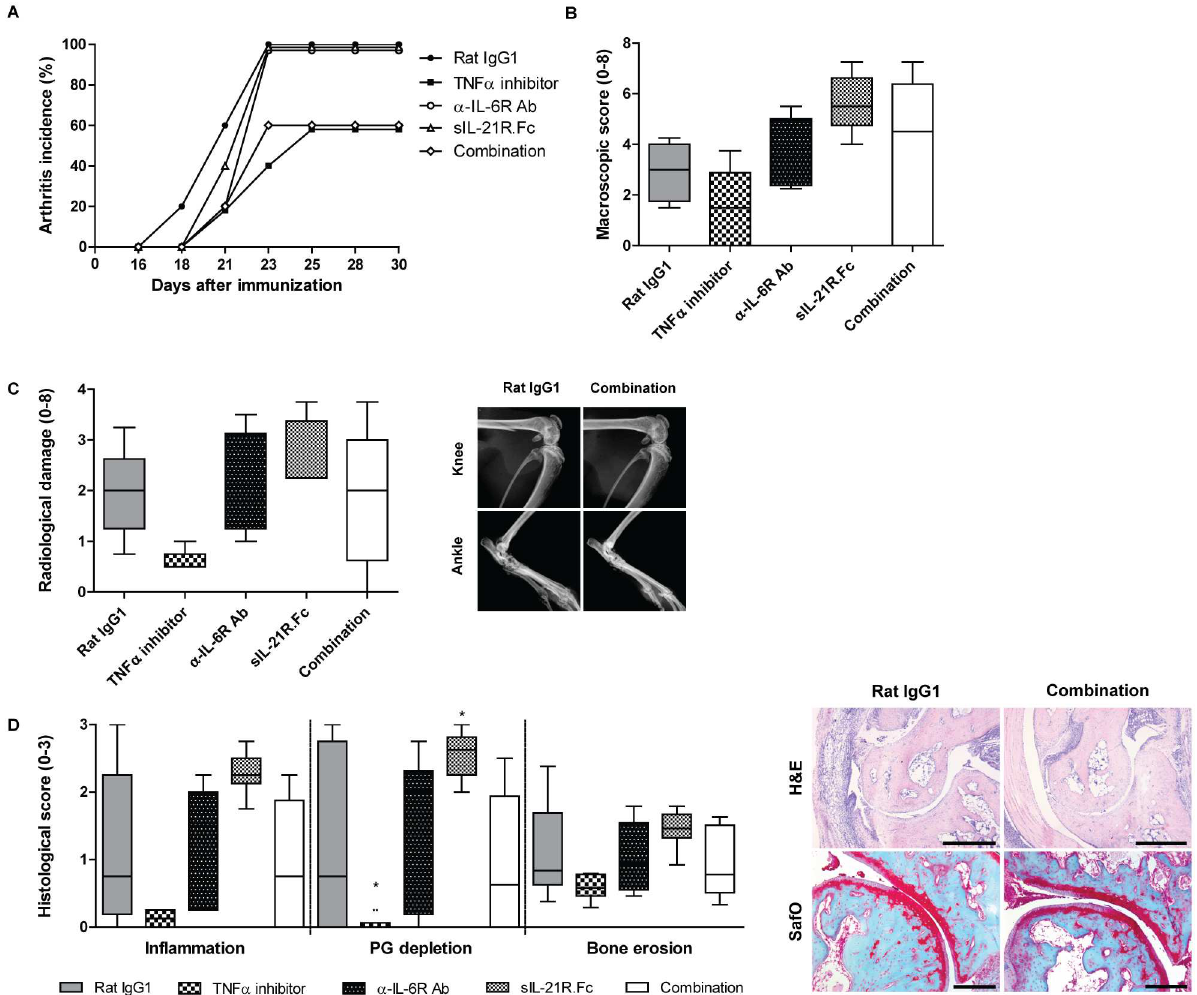
Fig 6. Arthritis incidence and severityof mice receiving anti-IL-6 and/or anti-IL-21 treatment late in disease development. Collageninducedarthritis was initiatedin DBA-1 mice, subsequently treated with anti-IL-6Rantibodiesand/or sIL-21R.Fc from the day of booster injection(d = 21; n = 5/group). Arthritis incidence(A) and severity (B) basedon macroscopicscoring. Bone damageas measured using the Faxitron depictedas radiologicaldamage(C). Histologically scored inflammation, bone erosion (both H&E staining,scale bar 500 μ M), and cartilageproteoglycan depletion(SafO staining,scale bar 200 μ M) (D). * p < 0.05versus Rat IgG1; One-way